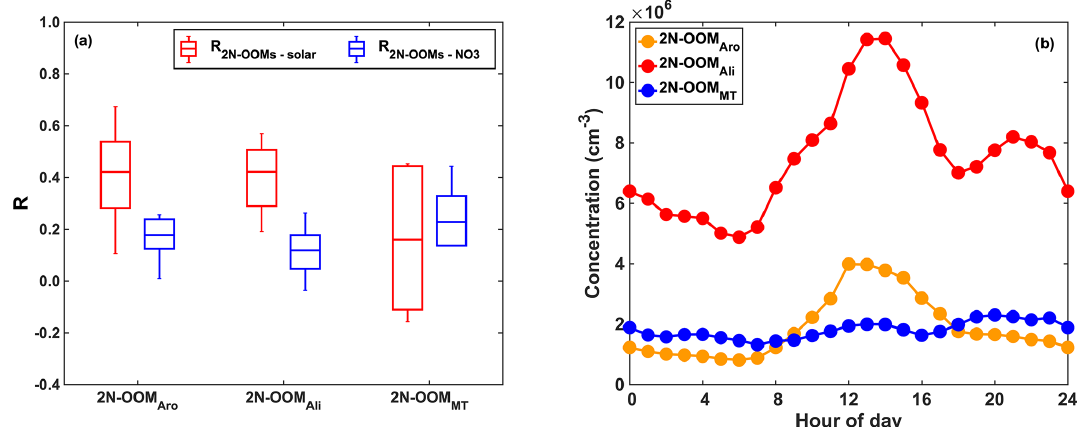
Figure 4. (a) Statistical distribution of the correlation coefficients (Spearman type) between 2N-OOMs and solar radiation ( R 2N-OOMs-solar ) in red and the correlation coefficients between 2N-OOMs and [NO 3 ] ( R 2N-OOMs-NO horizontal lines are the median values, boxes denote the 25th- and 75th-percentile values, and whiskers represent the 10th- and 90th-percentile values. (b) The diel patterns of 2N-OOMs from different precursors.